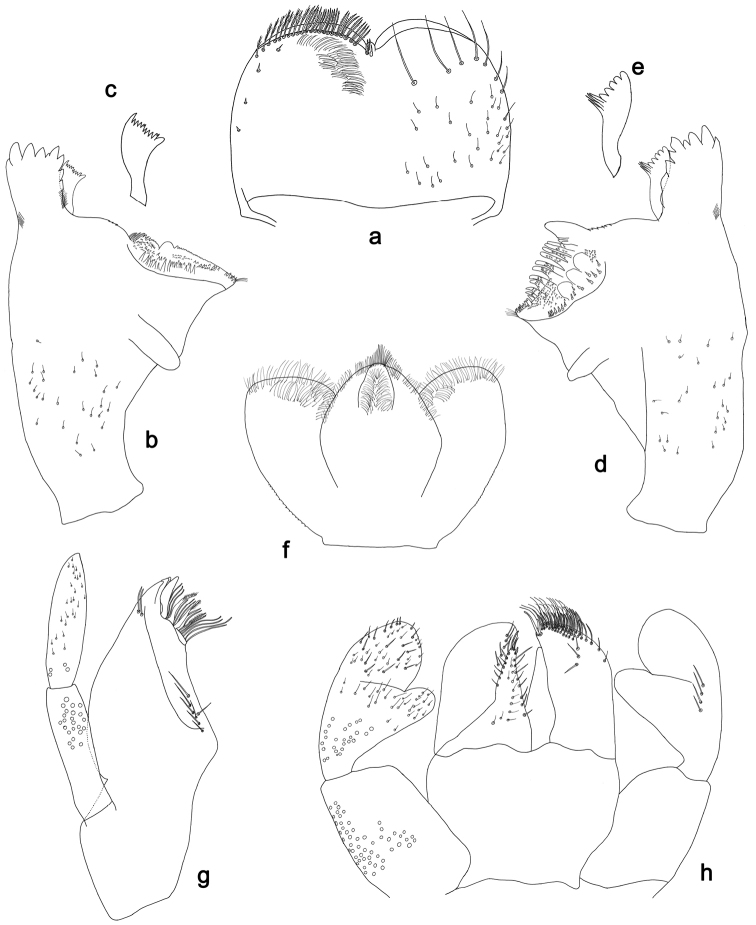
Labiobaetiscentralensis sp. n., larva morphology: a Labrum b Right mandible c Right prostheca d Left mandible e Left prostheca fHypopharynxg Maxilla h Labium.